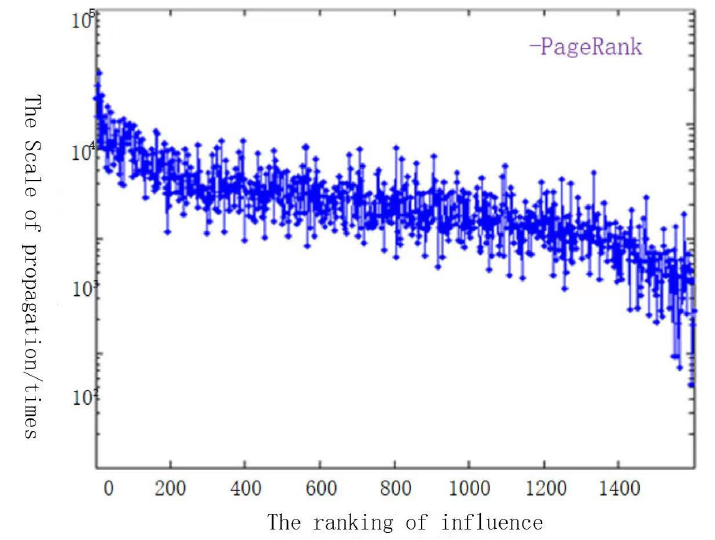
Figure 13. The relationship between the amount of reposting and user